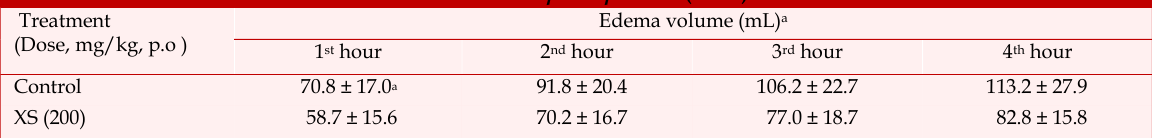
Measurement of hind paws volume (x1,000) at different time intervals after the administration of crude ex- tract of Xeromphis spinosa (n = 6) Treatment (Dose, mg/kg, p.o